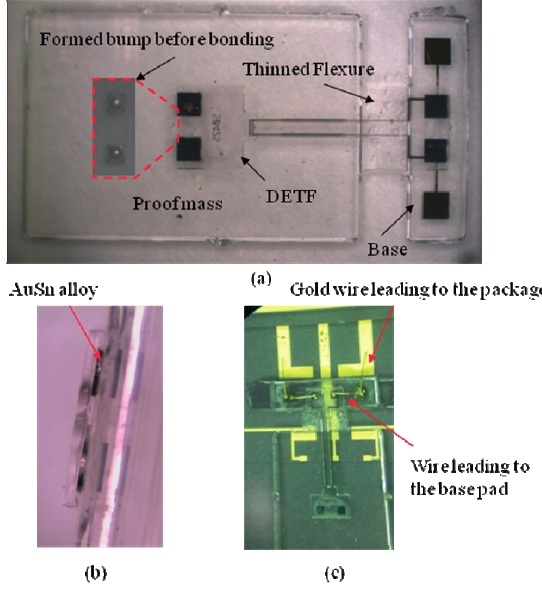
Figure 7. Bonding and packaging of sensor chip: ( a ) Optical picture of base-proof mass structure; ( b ) Side view of the bonding of DETF and base-proof mass structure; ( c ) Close-up picture of the electrodes connection and assembly on the ceramic